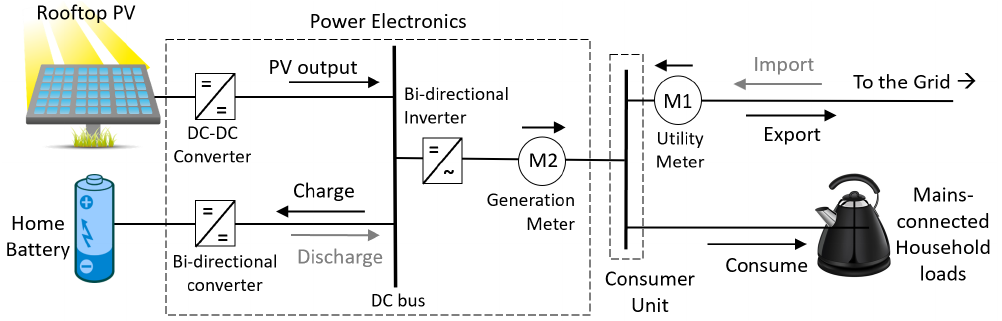
Figure 1. Schematic of DC-coupled domestic PV-battery